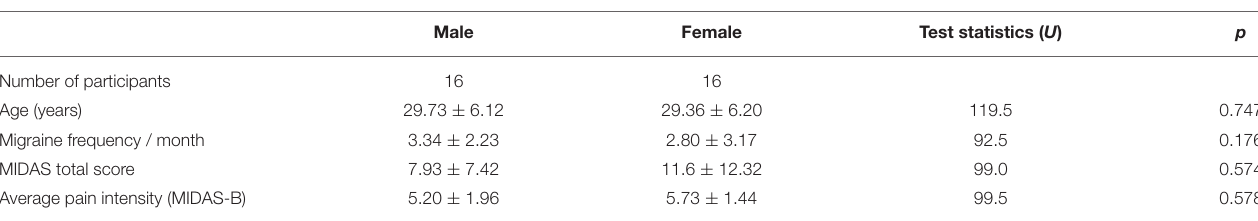
TABLE 1 | Characteristics of the